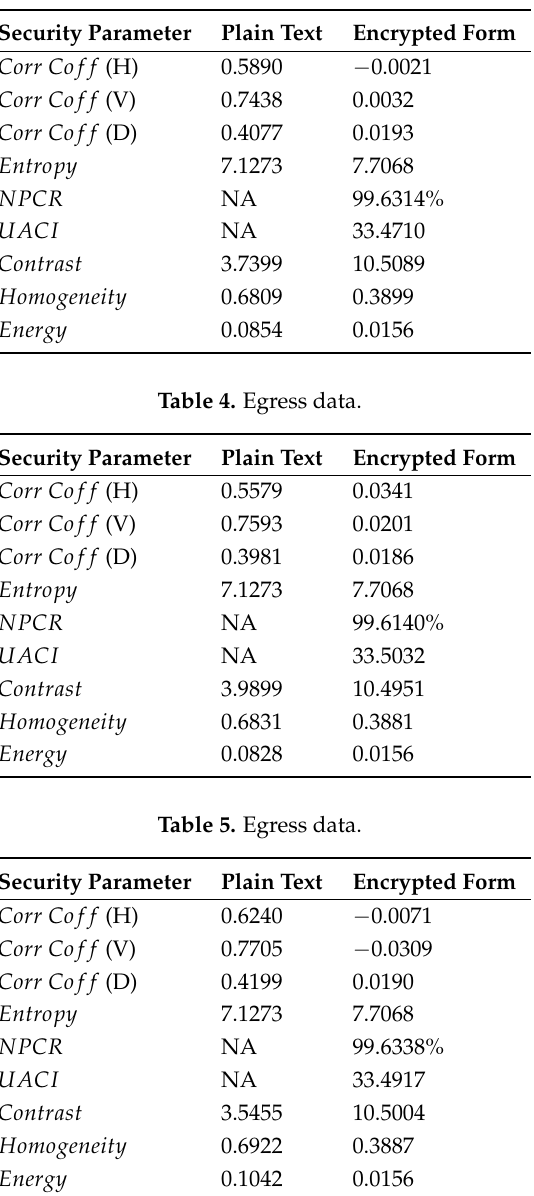
Table 3. Access data.